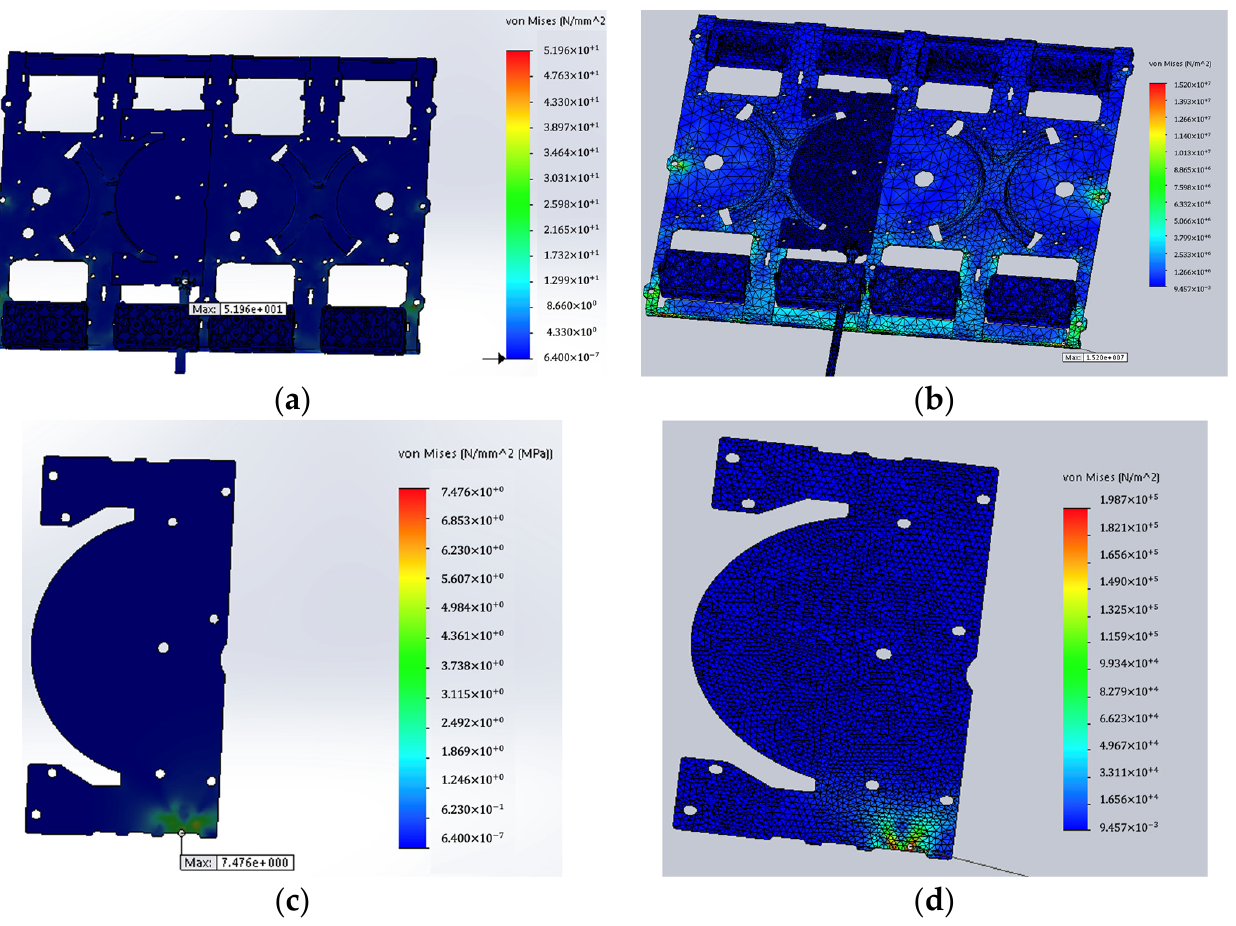
Figure 15. Simulation result of the original design and the improved design: ( a ) stress on the original design; ( b ) stress on the improved design; ( c ) stress on the PCB of the original design; ( d ) stress on the PCB of the improved design.